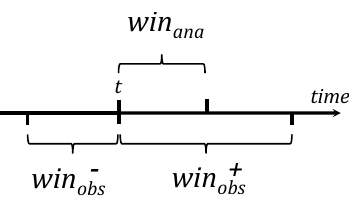
Figure 3. Schematic representation of the optimization window (win ana ), the backward (win − ) observation window and the for- obs ward (win + ) observation window. t is the beginning of win ana obs